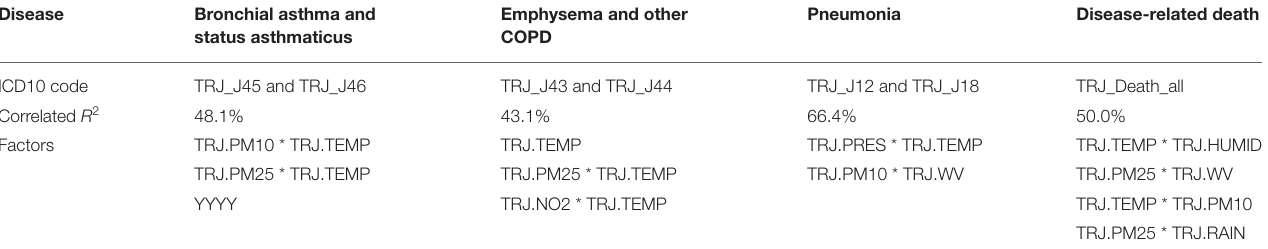
TABLE 1 | GRM that consider interactions of air pollution and meteorological factors of the selected diseases and disease-related deaths in the Tri-City, 2010–2018. Disease